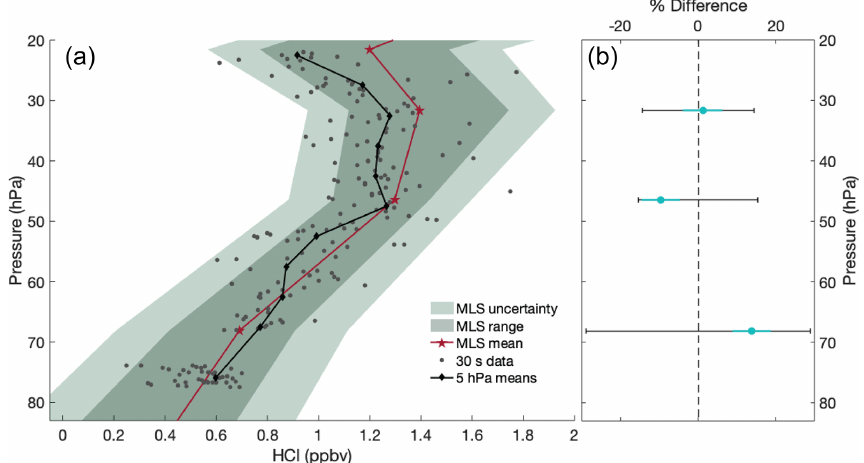
Figure 10. (a) Profile of HCl observed during HUSCE in comparison to nearby MLS observations on 24 August 2018. Grey dots represent 30s HCl data from the balloon, and black diamonds represent the vertical average of these data in 5hPa bins. Red stars represent the average of 11 nearby MLS observations; the dark green shading shows the range of MLS observations, and the light green shading shows the MLS uncertainty. (b) Percent differences between HUSCE observations and the mean of the closest two MLS observations that day, relative to MLS, are shown as cyan dots. Black error bars represent the relative uncertainty for MLS observations, and cyan error bars represent the uncertainty in accuracy for the HITRAN